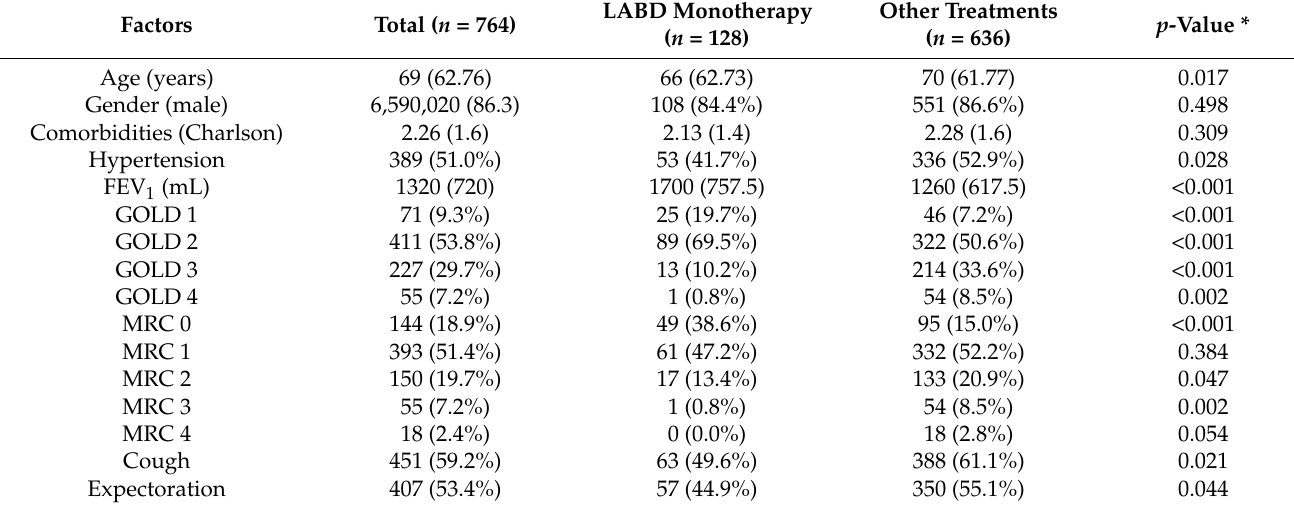
Table 1. Description of chronic obstructive pulmonary disease (COPD) cases with long-acting bronchodilator (LABD) monotherapy vs. other